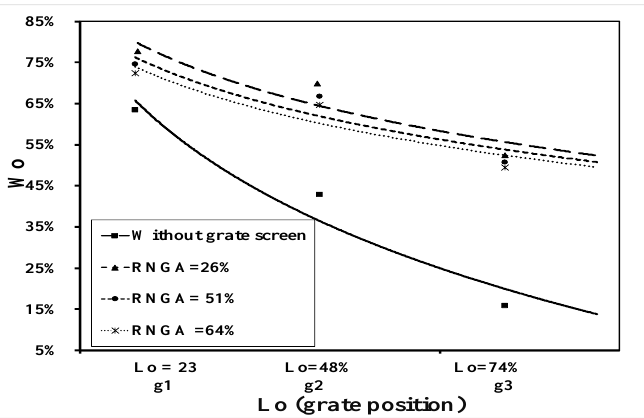
Figure 14. Relationship between relative width and relative grate distance for different grate inlet areas (Q = 1.2 L/s).